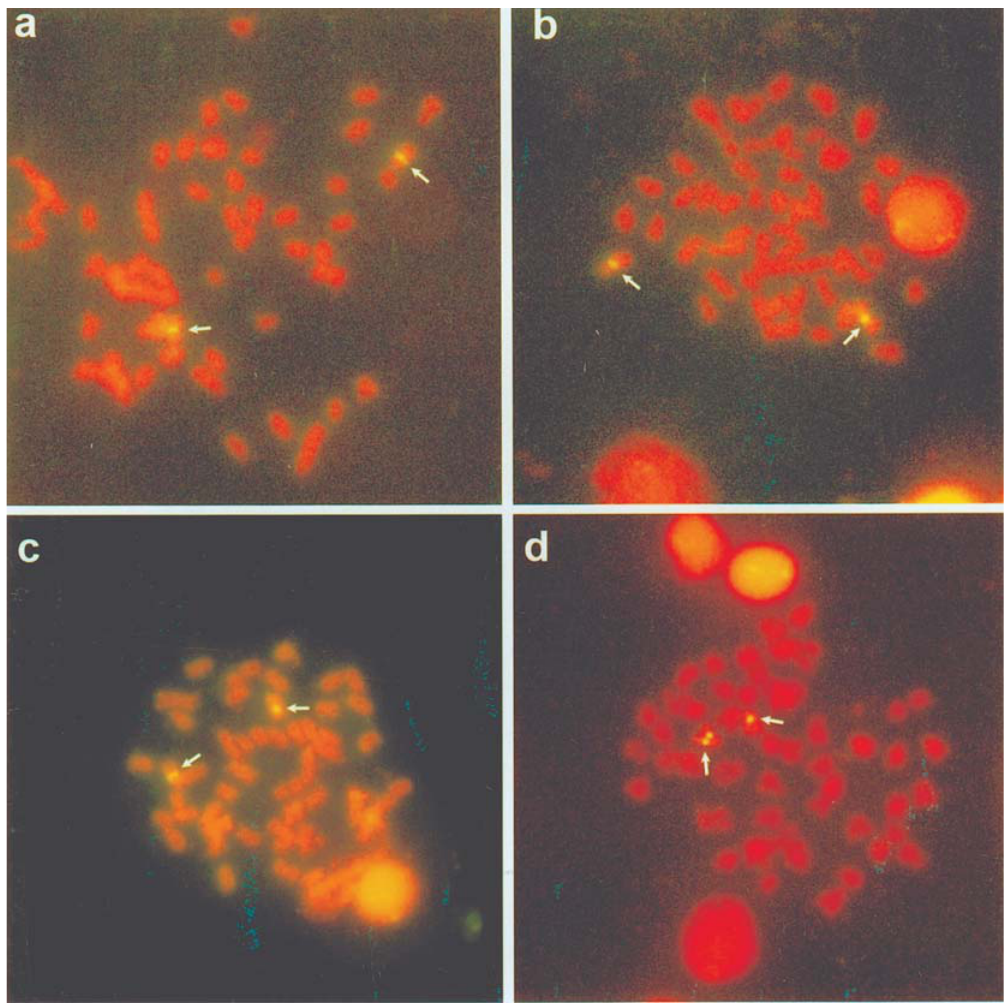
Figure 2 - Fluorescence in situ hybridization (FISH) Astyanax altiparanae metaphases showing the chromosomal location of 5S rDNA sites in popula- tions from the Maringá stream (a), Paraná river (b), Keçaba stream (c) and Tatupeba stream (d). The arrows indicate the ribosomal cistrons carrier chro-